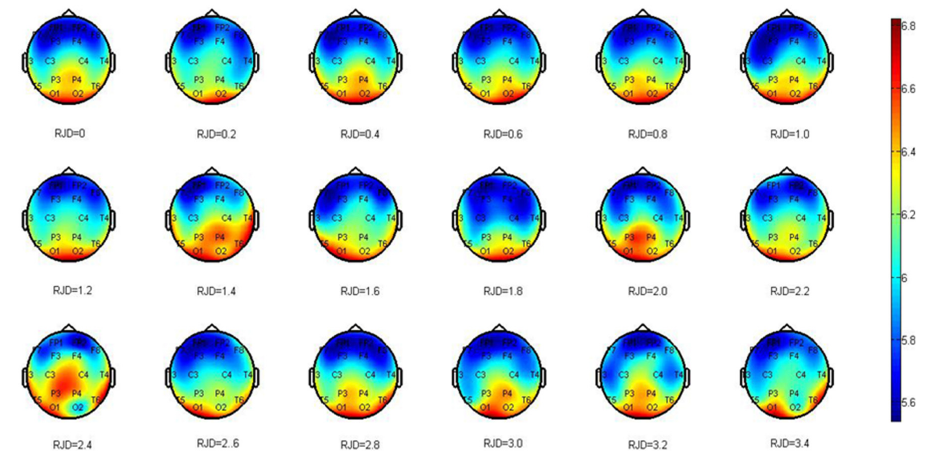
Fig. 2. The distribution of GF in di®erent channels on the scalp. The color bar referred to the range of GF.